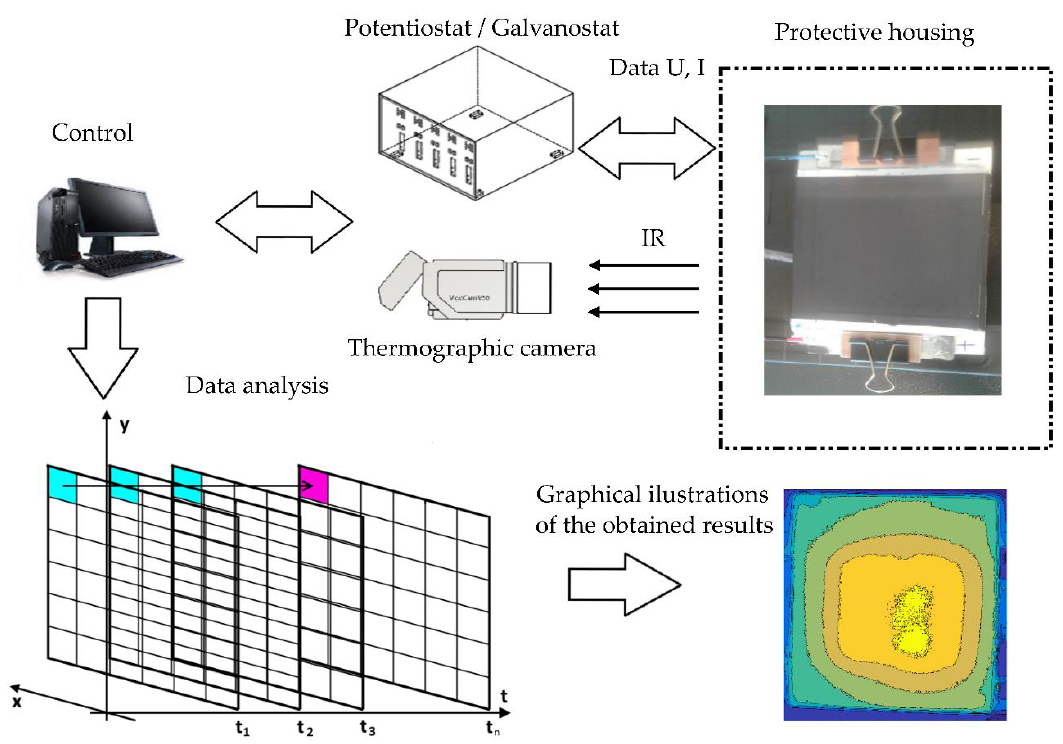
Figure 2. Graphical illustration of exemplary thermographic results.